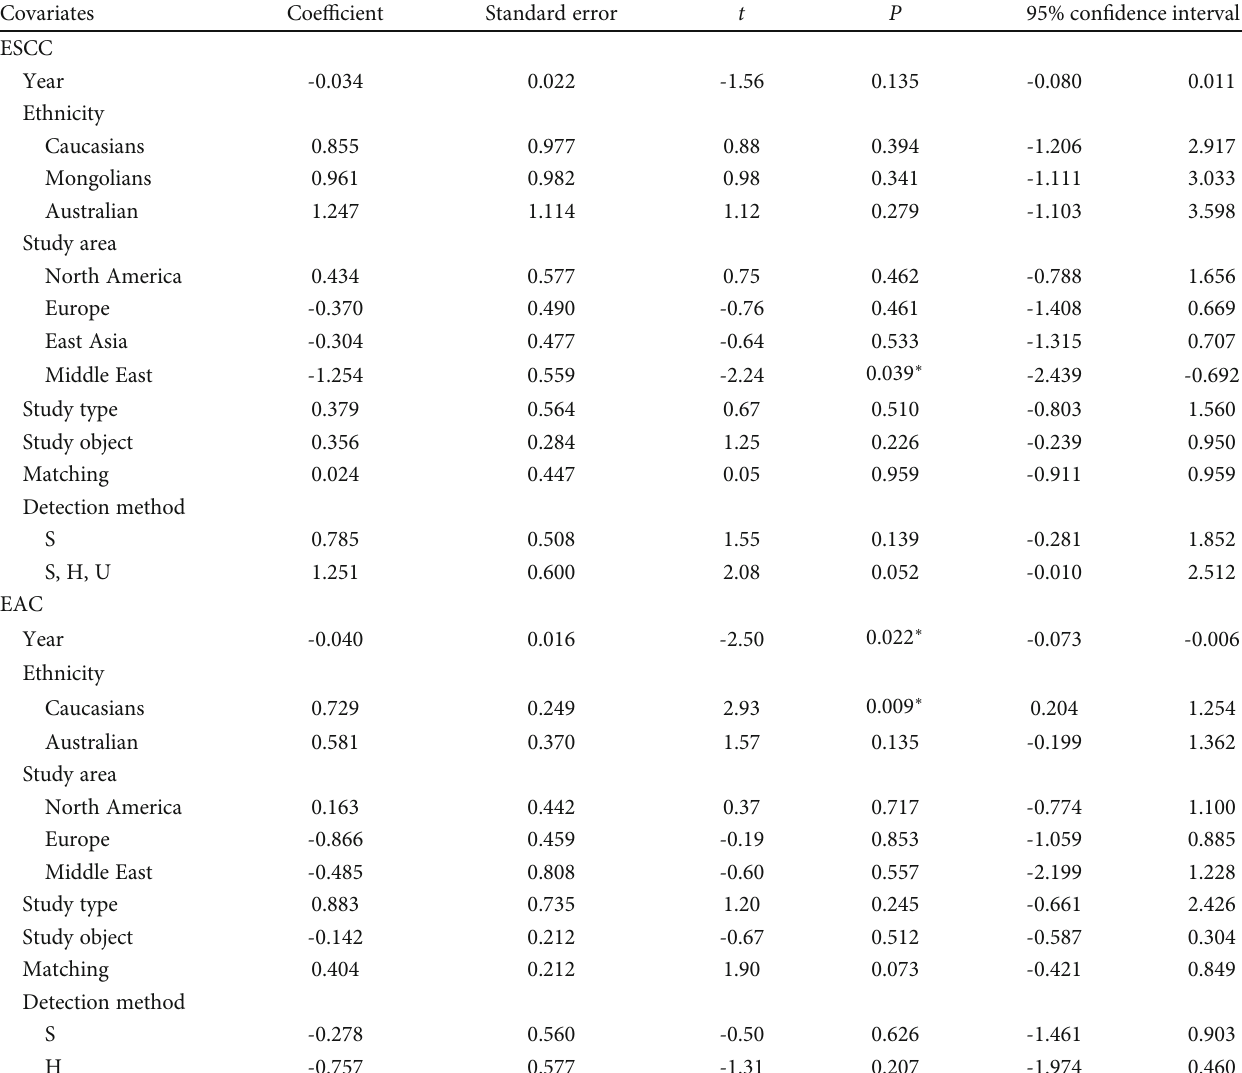
Table 4: Univariate metaregression analysis for the potential variables between